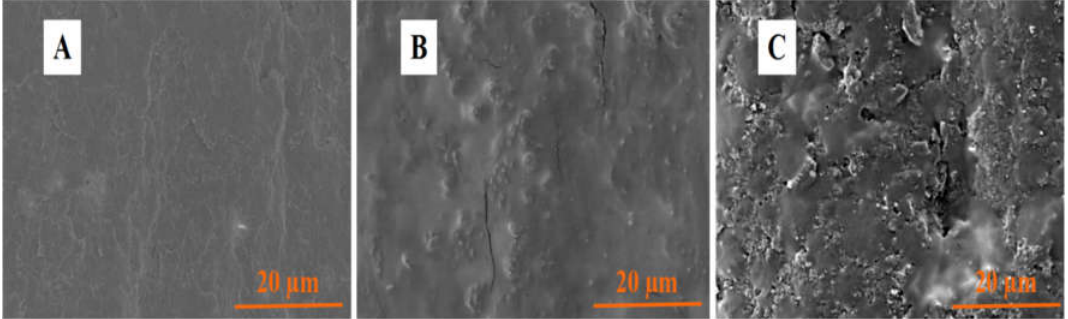
Figure 3. SEM images of bare PGE ( A ), PTP/PGE ( B ) and PTP–AgNP/PGE ( C ).